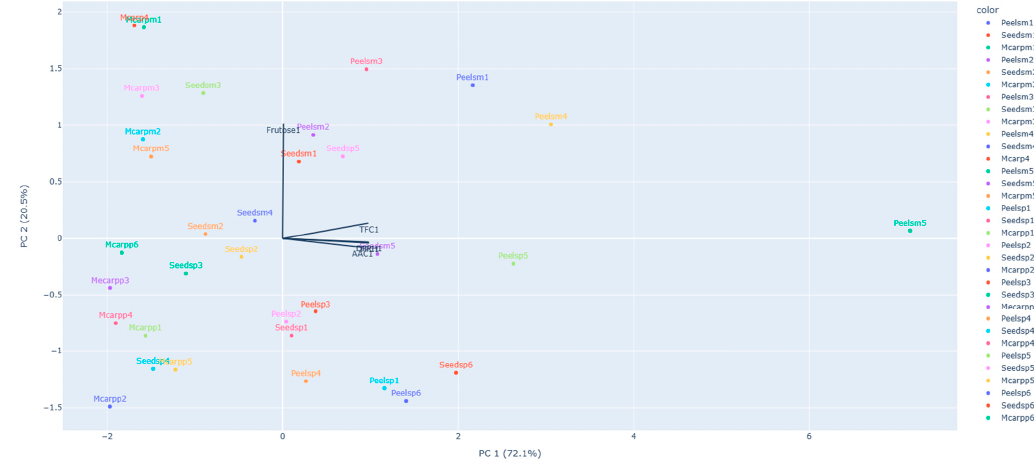
Figure 2. Biplot PC2 vs. PC1 for different apple and peer varieties and for the different parts of the fruits. (Peelsm1: Peel of Pêro Coimbra Apple, Seedsm1: Seeds of Pêro Coimbra Apple, Mcarpm1: Pulp of Pêro Coimbra Apple, Peelsm2: Peel of Pardo Lindo Apple, Seedsm2: Seeds of Pardo Lindo Apple, Mcarpm2: Pulp of Pardo Lindo Apple, Peelsm3: Peel of Repinau Apple, Seedsm3: Seeds of Repinau Apple, Mcarpm3: Pulp of Repinau Apple, Peelsm4: Peel of Pêro de Borbela Apple, Seedsm4: Seeds of Pêro de Borbela Apple, Mcarpm4: Pulp of Pêro de Borbela Apple, Peelsm5: Peel of Noiva Apple, Seedsm5: Seeds of Noiva Apple, Mcarpm5: Pulp of Noiva Apple, Peelsp1: Peel of Bela-Feia Pear, Seedsp1: Seeds of Bela-Feia Pear, Mcarpp1: Pulp of Bela-Feia Pear, Peelsp2: Peel of Torres Novas Pear,